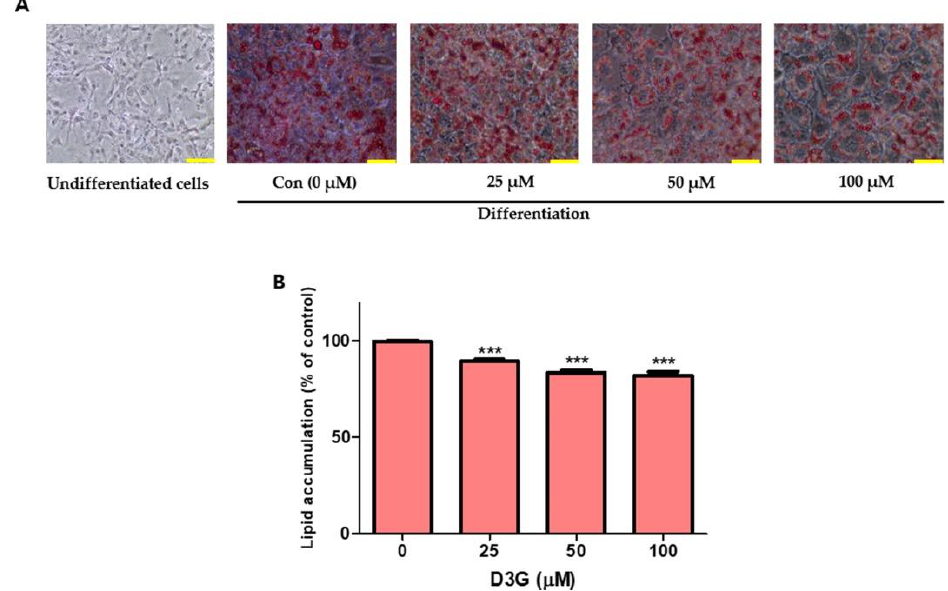
Figure 2. E ff ect of delphinidin-3- O - β -glucoside (D3G) on lipid accumulation in 3T3-L1 adipocytes. ( A ) Photomicrographs of lipid droplets in control (Con) and D3G (25, 50, and 100 µ M)-treated cells measured by Oil Red O staining. ( B ) The percentage of lipid accumulation in D3G-treated and control cells. Data represent the mean ± SEM of three di ff erent experiments. *** p < 0.001 vs. 0. Scale bar ( A ) indicates 100 µm.